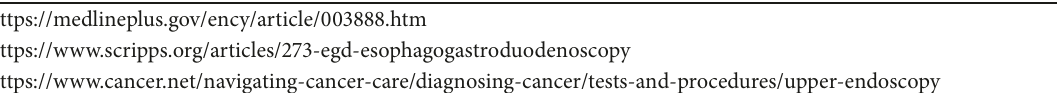
Table 6: Websites with moderate quality content and readability level of 8th grade and